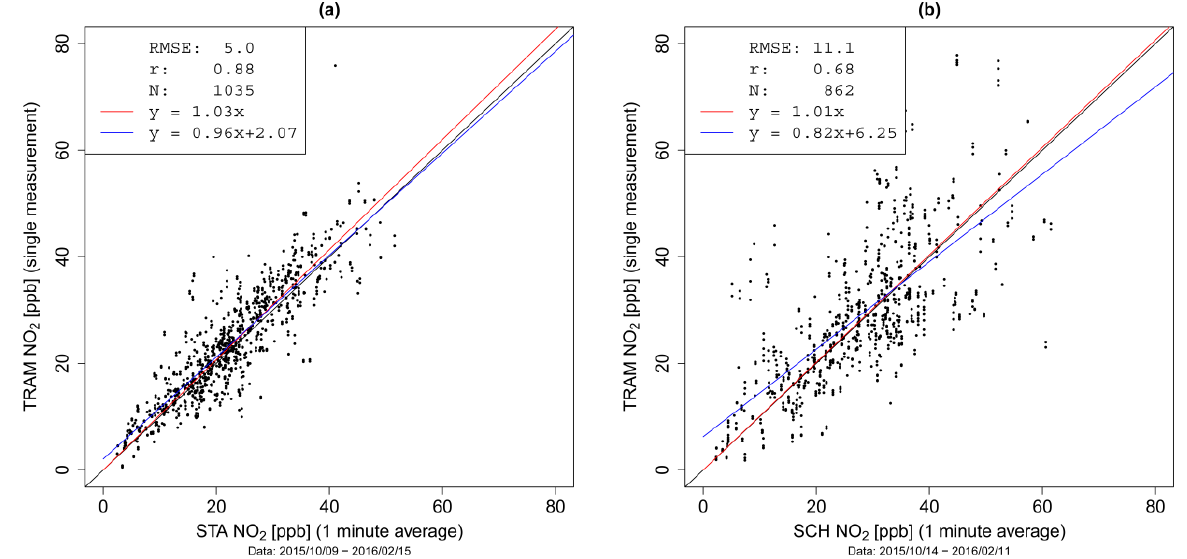
Figure 8. Comparison of QCLAS data with measurement values (1min average) from the AQM sites STA (a) and SCH (b) when the tram is within a 30m radius from the respective AQM site.